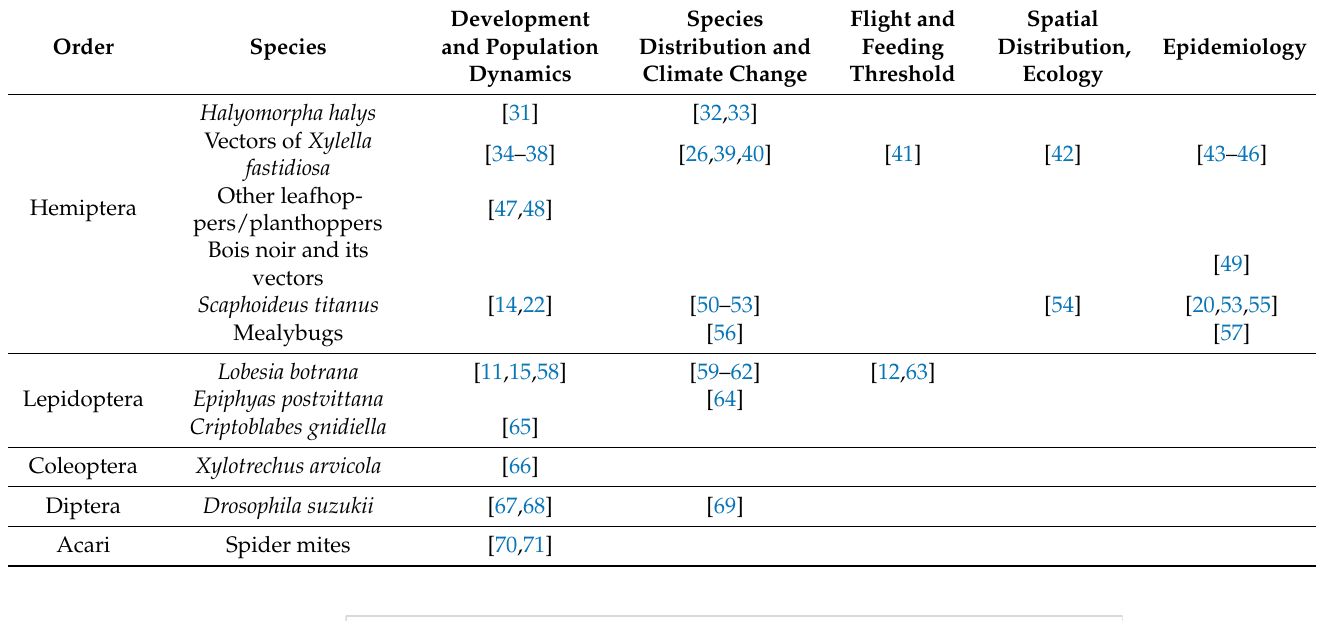
Table 1. List of published models investigating different biological aspects of grapevine pests.